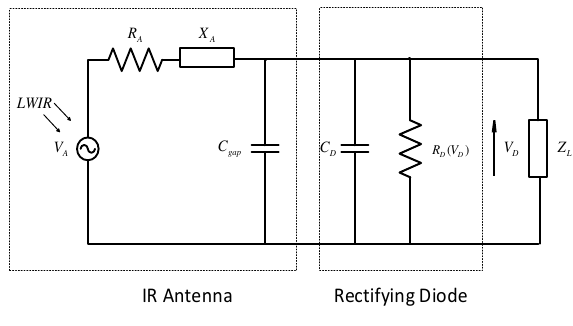
Figure 8: Circuit model of IR antenna coupled to rectifying